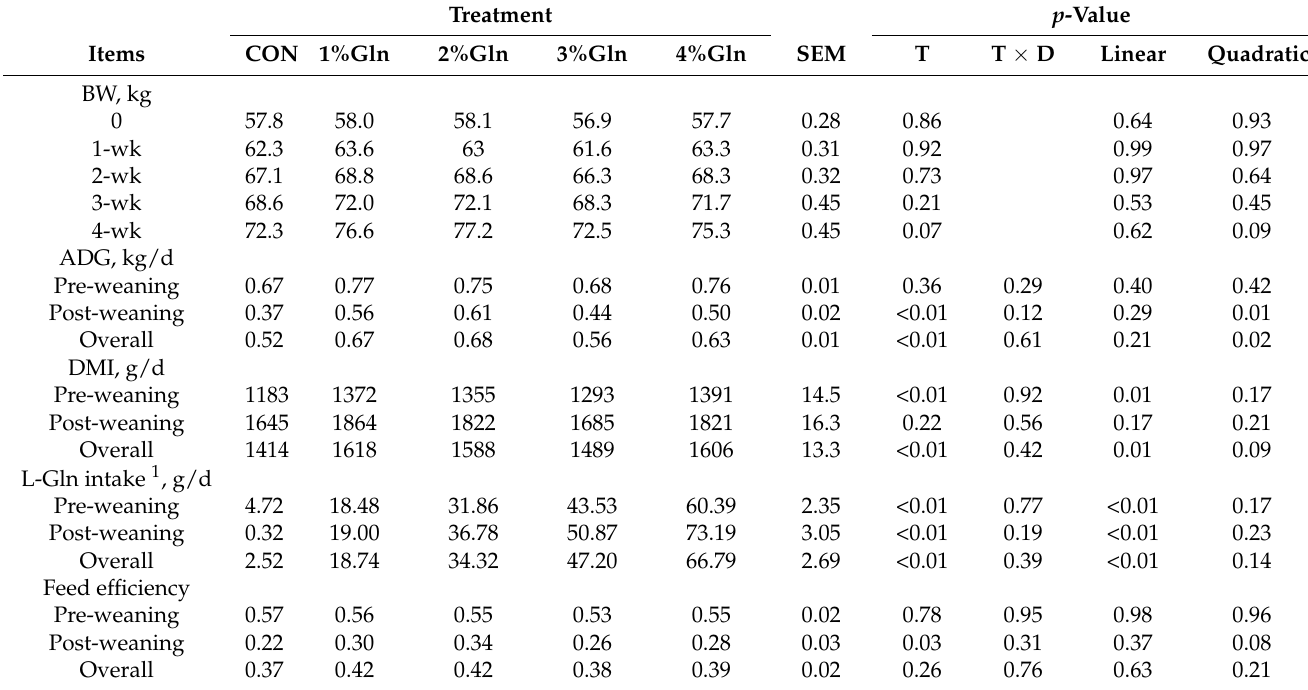
Table 1. Growth performance and feed intake of calves during different treatments (N = 15 per